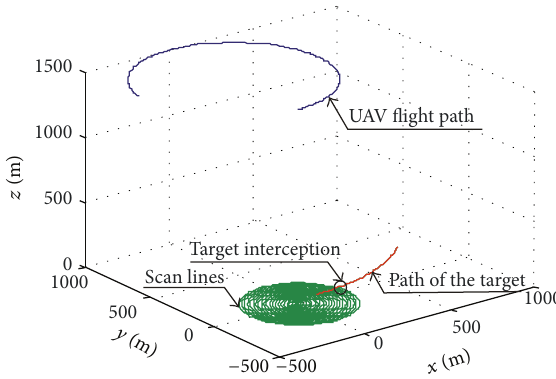
Figure6:PathofmovementofUAV,headaxis,andthetargetduring searching for and tracking the target.